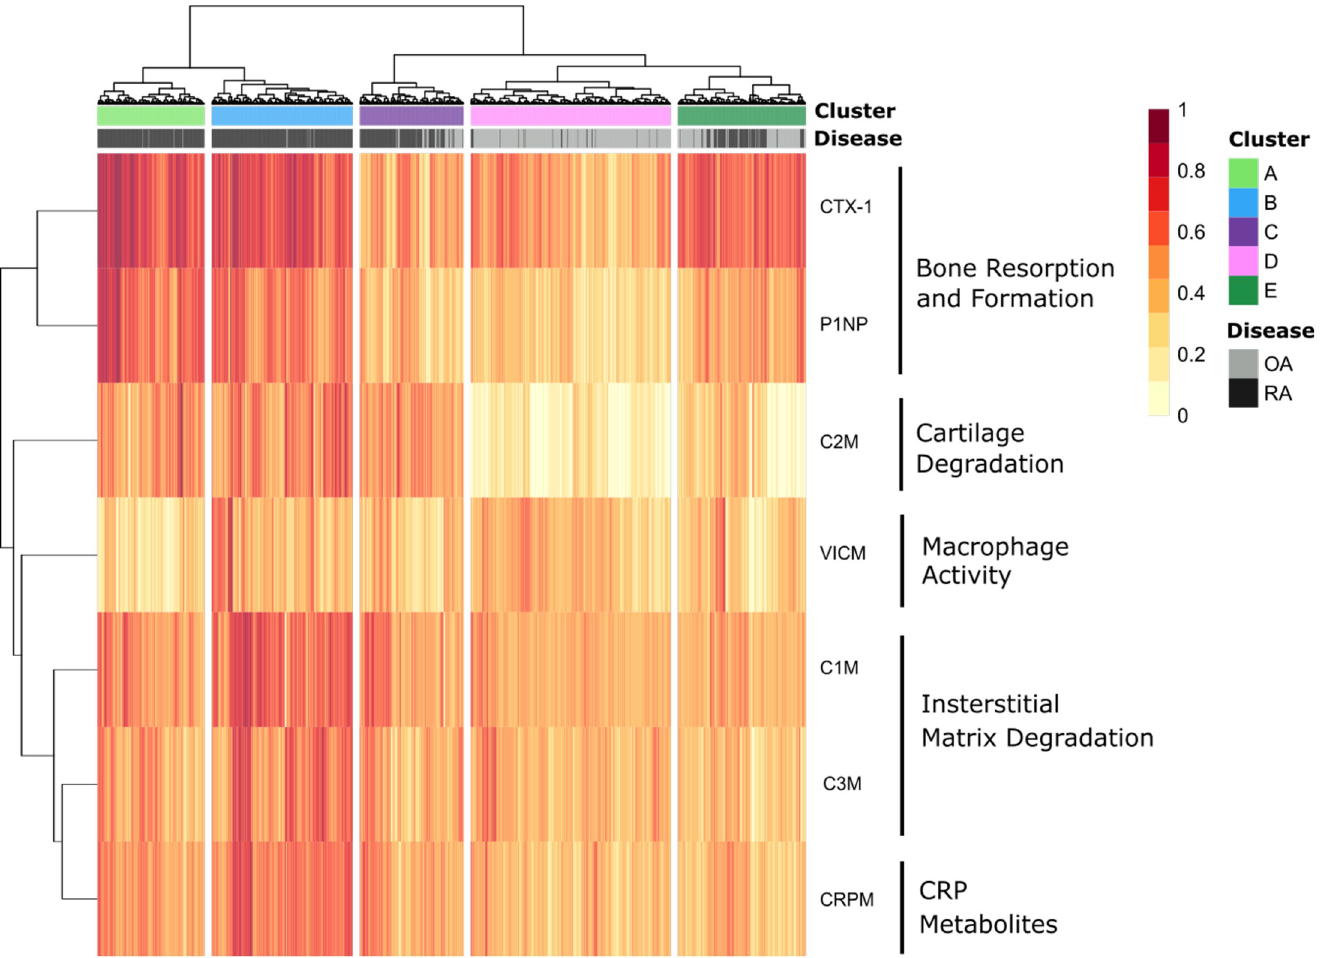
Fig 2. 1233 patients from 4 clinical trials; two rheumatoid arthritis (RA) and two osteoarthritis (OA), were clusters based on 7 tissue specific blood based biomarkers measuring bone resorption and formation, cartilage degradation, macrophage activity, interstitial matrix degradation and CRP metabolites. 5 clusters were found with two high inflammatory RA endotypes and one low inflammatory RA endotype, and a final “mixed” endotype. OA patients were clearly separated from RA patients as expected.